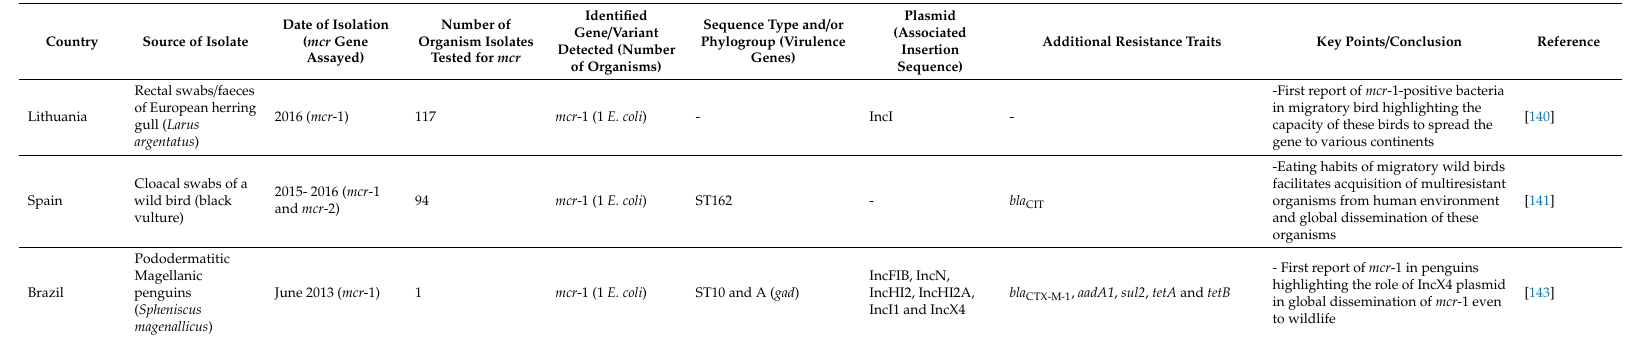
Table 7. Studies reporting plasmid-mediated colistin resistance in wildlife (mammals, birds and